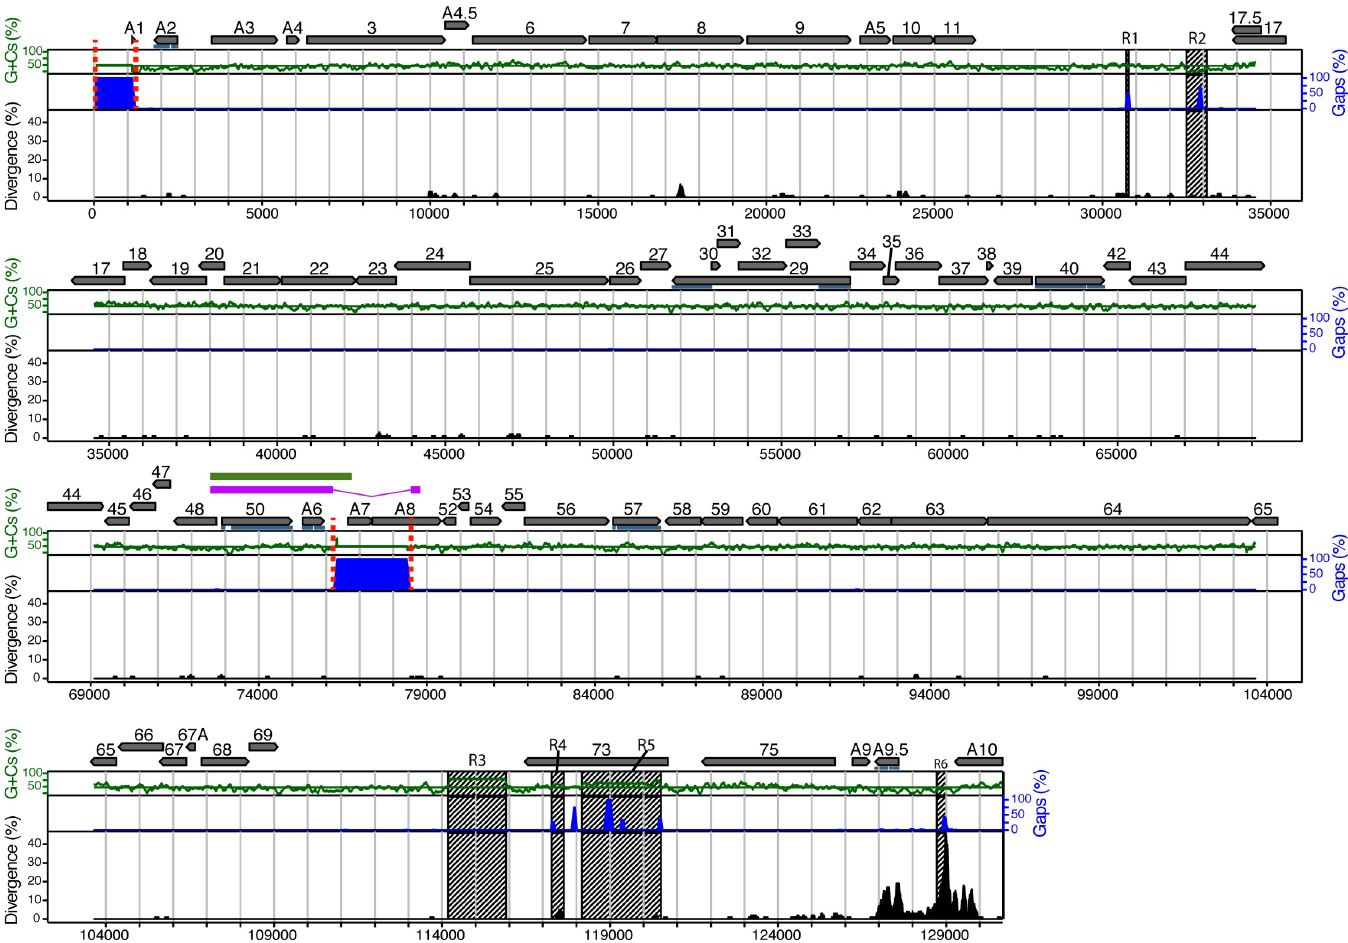
Fig 1. Attenuated AlHV-1 strain WC11 lacks gene A7 and part of gene A8. The illustration is based on an alignment of the LUR sequences of WC11 and C500. Genome features are represented in the upper part in relation to the C500 sequence (GenBank accession AF005370) [37]. Protein-coding regions and their orientations are depicted by grey arrows, with the ORF prefix omitted for those not prefixed by A. Exons are indicated by horizontal blue lines. Percentage divergence is shown by the black-filled curve, percentage insertions and deletions by the blue-filled curve, and percentage G+C content by the green curve, with mean G+C content shown as a horizontal green line. These percentages were measured in a 100 bp window with 3 bp increments. Tandem repeat regions (R1 to R6) are depicted as hatched areas. The magenta bar shows region duplicated in the TR of WC11. The green bar shows region duplicated in the TR of C500. Regions absent from WC11 are flanked by dotted red